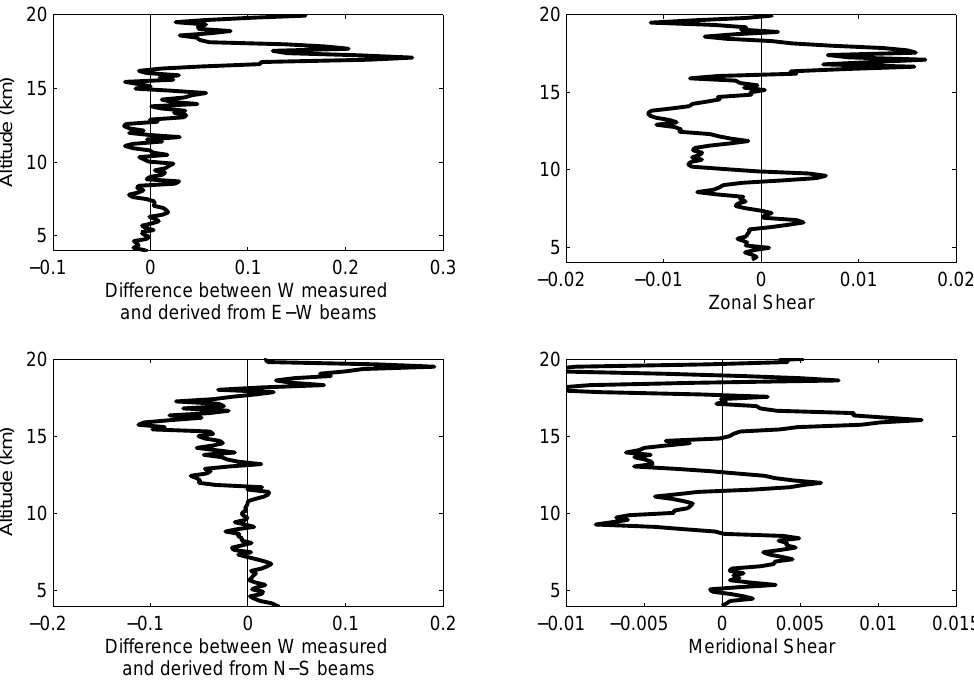
Fig. 7. Height variation of difference between measured vertical wind and derived from E-W radial beams (upper left panel), height variation of zonal shear (upper right panel) and similar variations but for N-S beams and meridional shear ( lower panels).